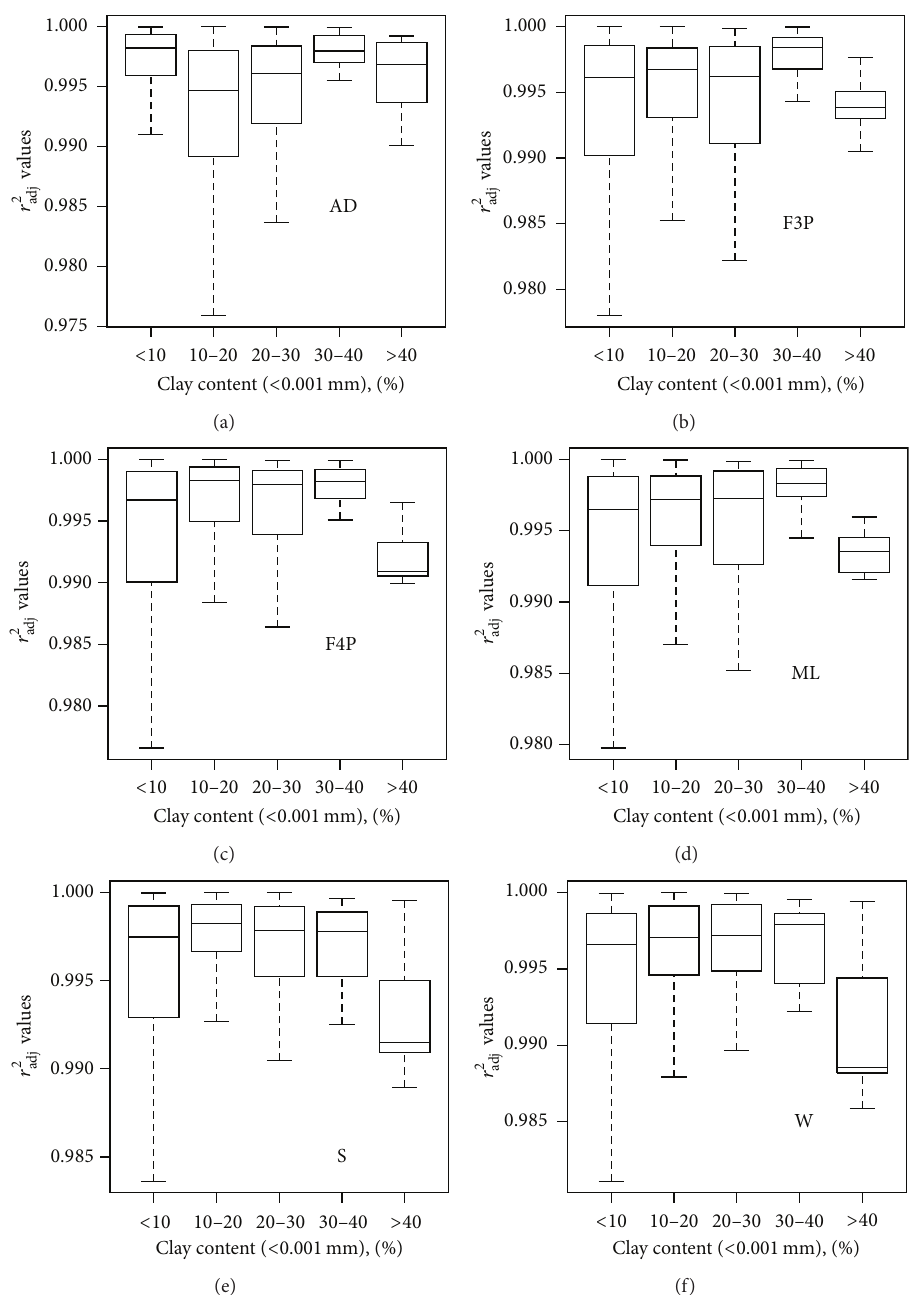
Figure 6: Box plot for 𝑟 2 percentiles of the PSD models on different clay content of soils in the T2 scheme. adj